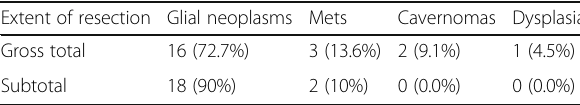
Table 4 Relation to the extent of resection and the histopathological